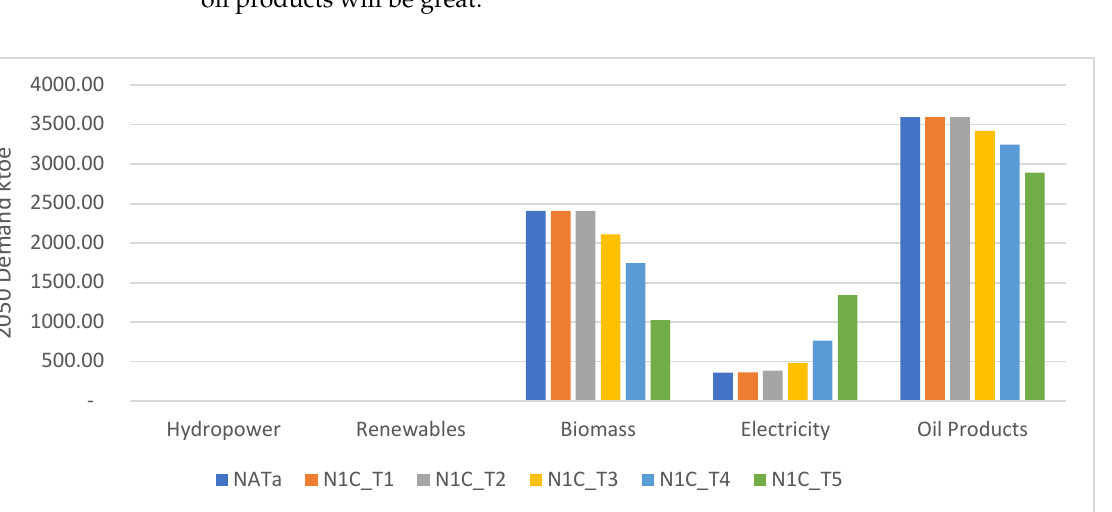
Figure 5. Energy demand by 2050 for scenarios based on NATb. For Mali to supply the demand by 2050 of any of the scenarios mentioned above, see Table 2, considerable increases in electricity generation capacity will be needed, be it from renewable or non-renewable sources. This is highlighted by the extra electricity needed, labeled “Electricity” in Error! Reference source not found. . Although, with the transition from biomass for cooking to oil products in the urban sector, this extra electricity is over- taken by the oil products requirement that will ensue, see Error! Reference source not found. .